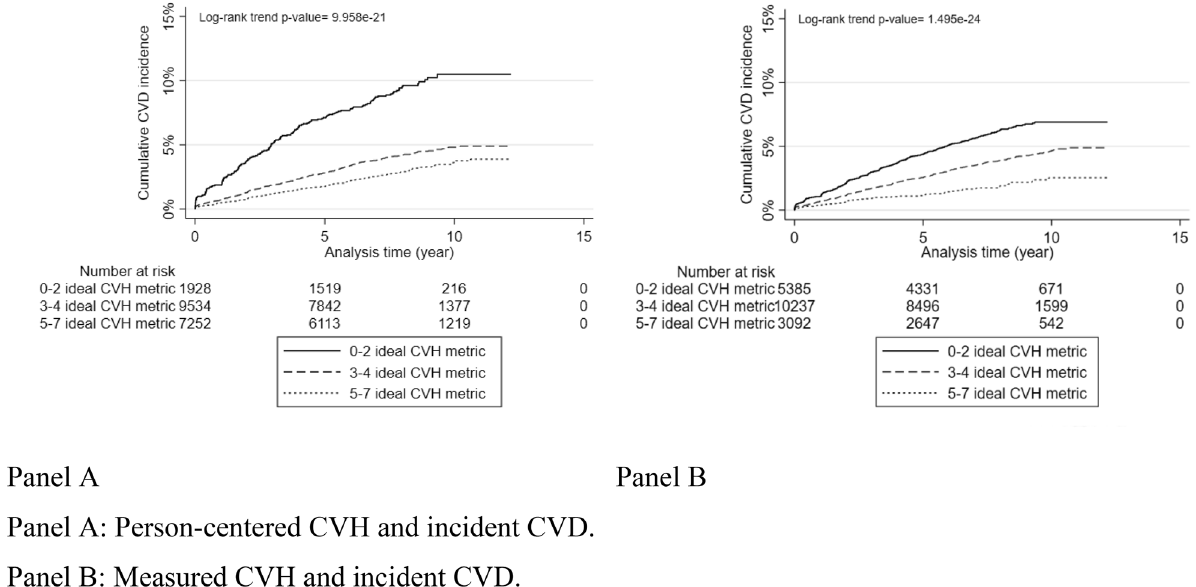
Figure 2. Kaplan–Meier curves showing CVD incidence for person-centered and measured CVH. Panel A: Person-centered CVH and incident CVD. Panel B: Measured CVH and incident CVD.